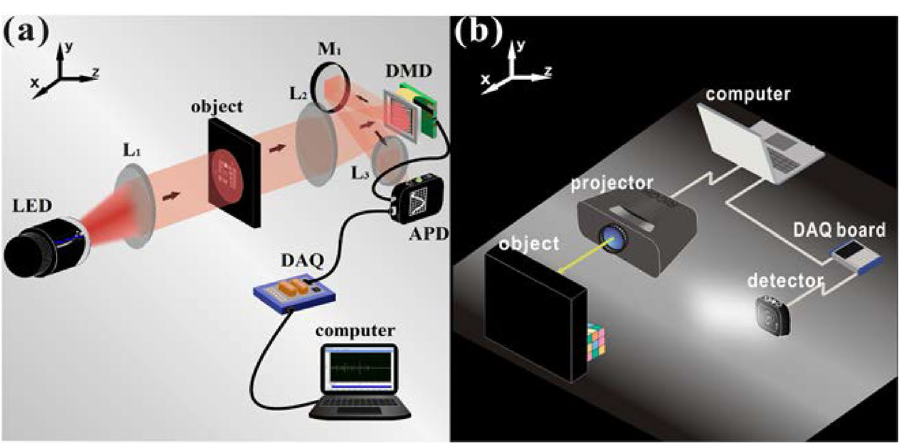
Figure 3. Schematic diagrams of the two experimental